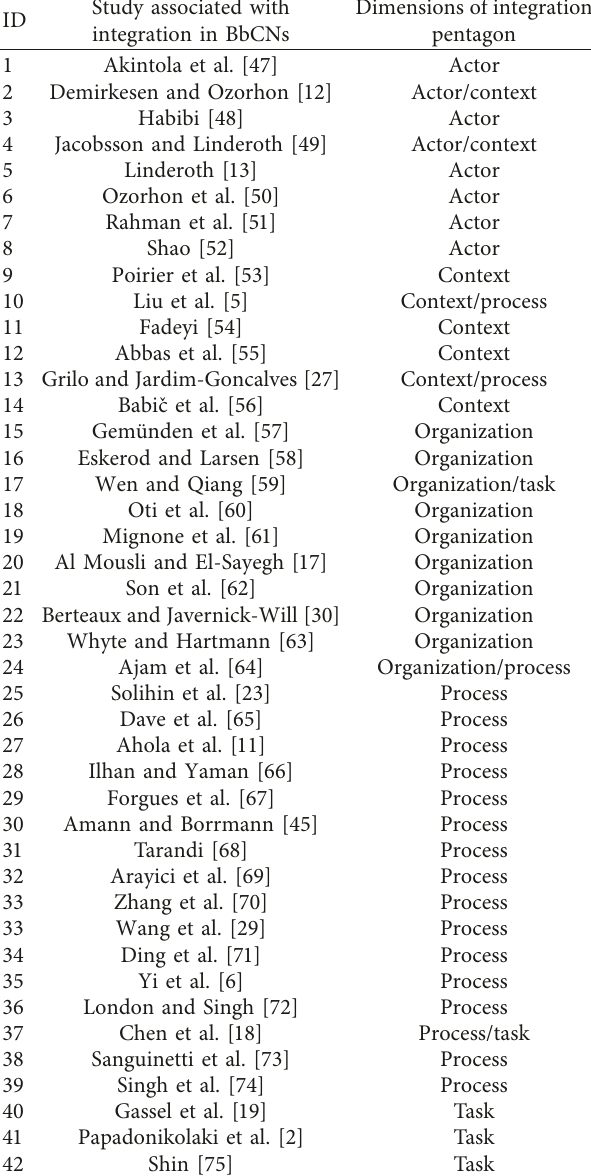
Table 1: Study associated with integration in BbCNs and the di- mensions targeted in each